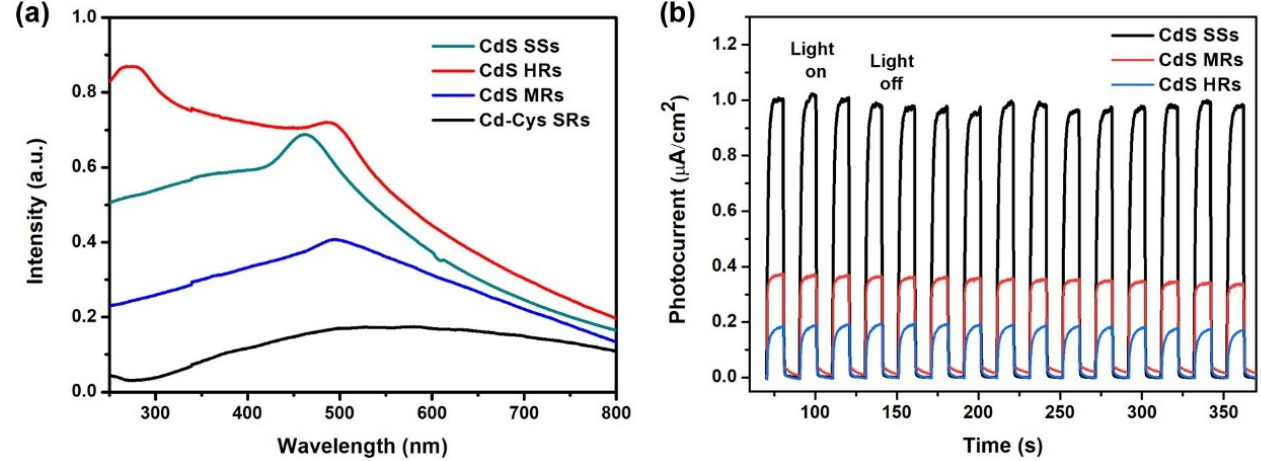
Figure 5. ( a ) UV–vis absorption spectra and ( b ) photocurrent responses of samples.